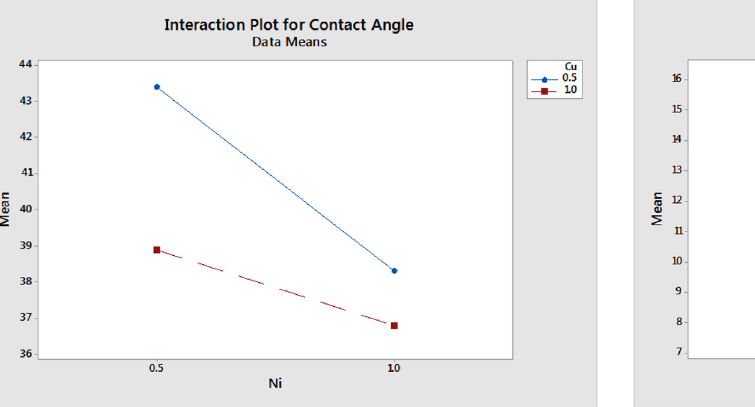
Fig. 4. Interaction plot for contact angle.